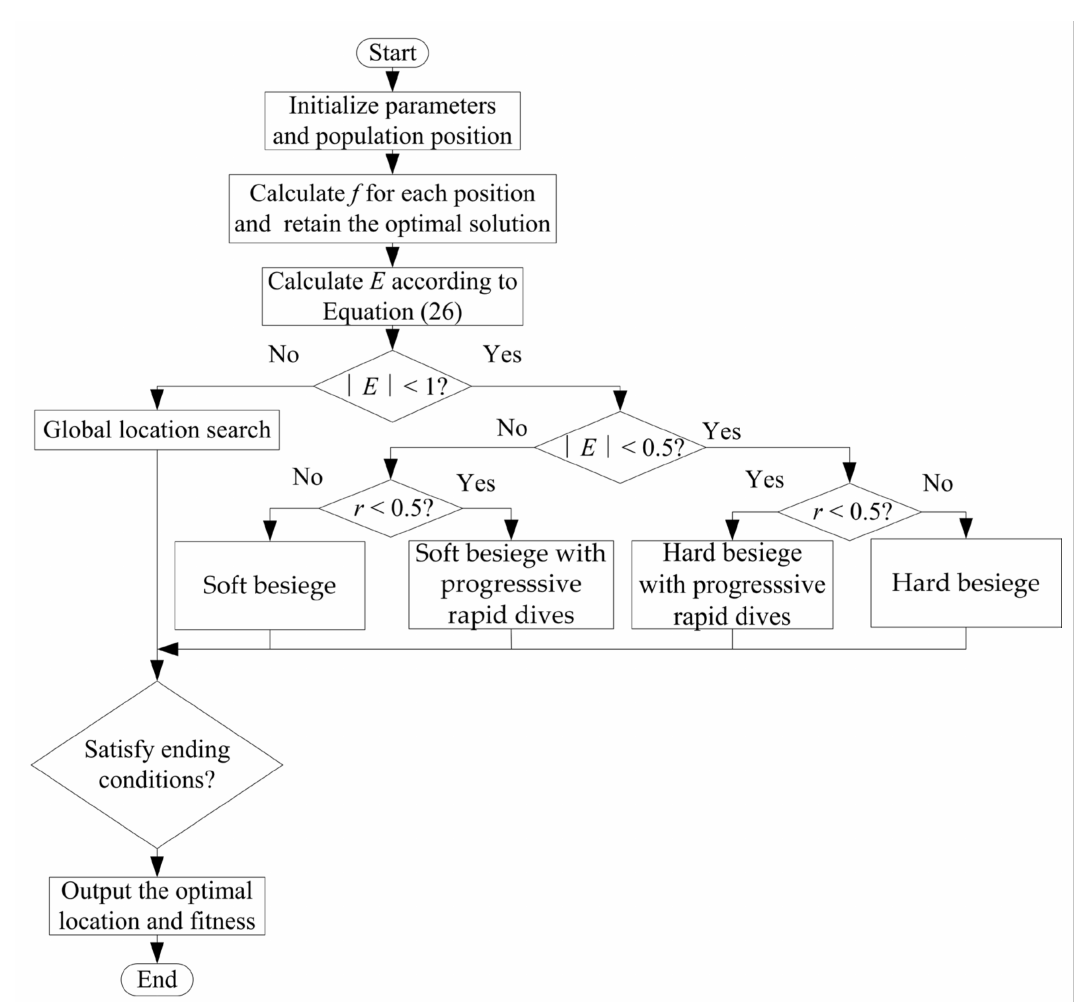
Figure 6. Flowchart of